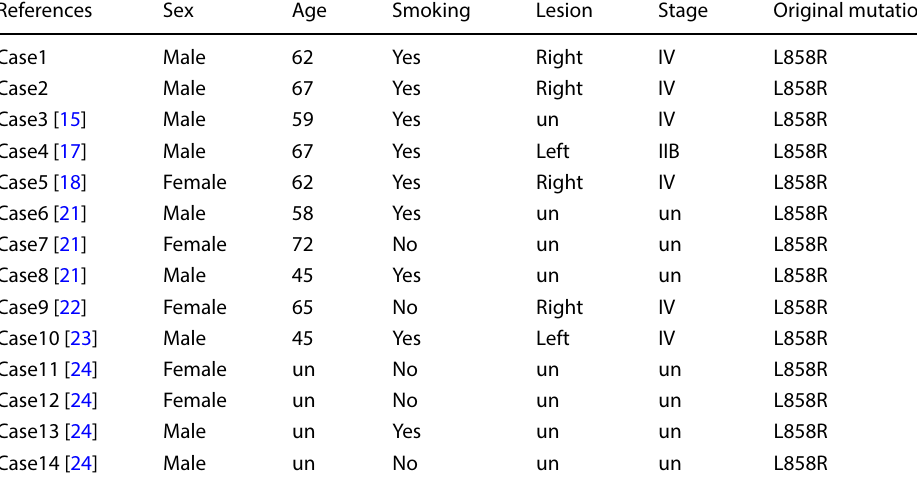
Table 1 Clinical characteristics of patients with L718Q/V mutations of EGFR exon